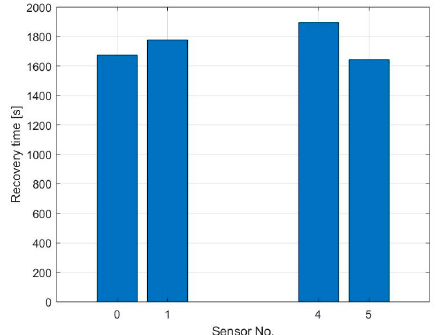
Figure 13. The graph shows the recovery time of sensors S 0 , S 1 , S 4, and S 5 after exposure to 10 ppm NH 3 while keeping the heater at a constant temperature of 250 °C. The sensor´s recovery time has been calculated as the time until the sensor´s output reaches the 90% of its stable recovered condition.